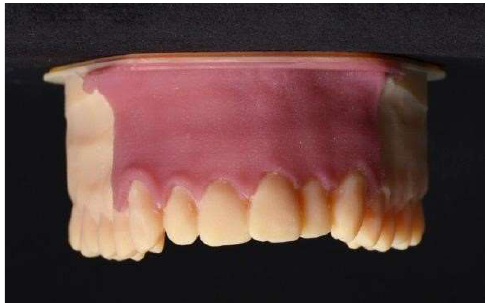
Figure 5. Silicone gingival mask.